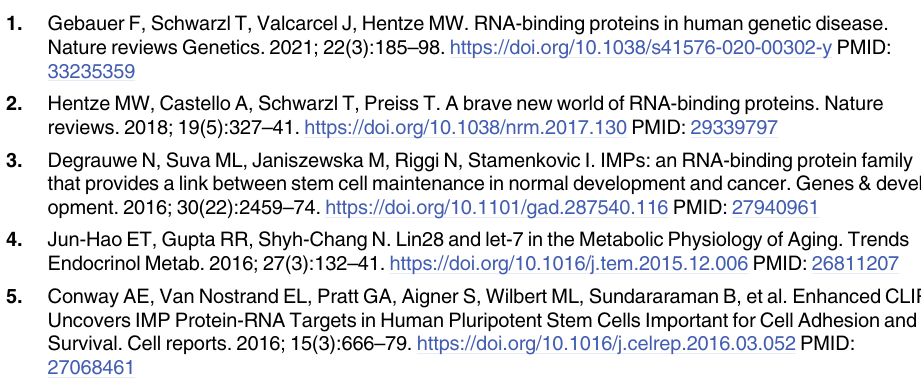
S6 Fig. Imp and Lin28 partially co-localize in the intestinal lineage under control condi- tions and after stress. (A) Representative confocal images showing the expression of GFP-Imp (green) and Lin28-mCherry (red) under control conditions and in response to DSS or para- quat for 24 hours. In all conditions, the two fusion proteins can be detected in partially over- lapping pattern in small diploid intestinal progenitors. DNA is stained with Hoechst. (B) Representative confocal images showing the expression of GFP-Imp (green) and Lin28-m- Cherry (red) after ex vivo treatment with Sodium Arsenite for 1 hour. Inserts a-f present higher magnification images of Imp, Lin28 and Imp+lin28 foci. Both under control conditions and after NaAsO , all three types of granules can be detected in intestinal progenitors. DNA is 2 stained with Hoechst. Scale bar: 3 μ